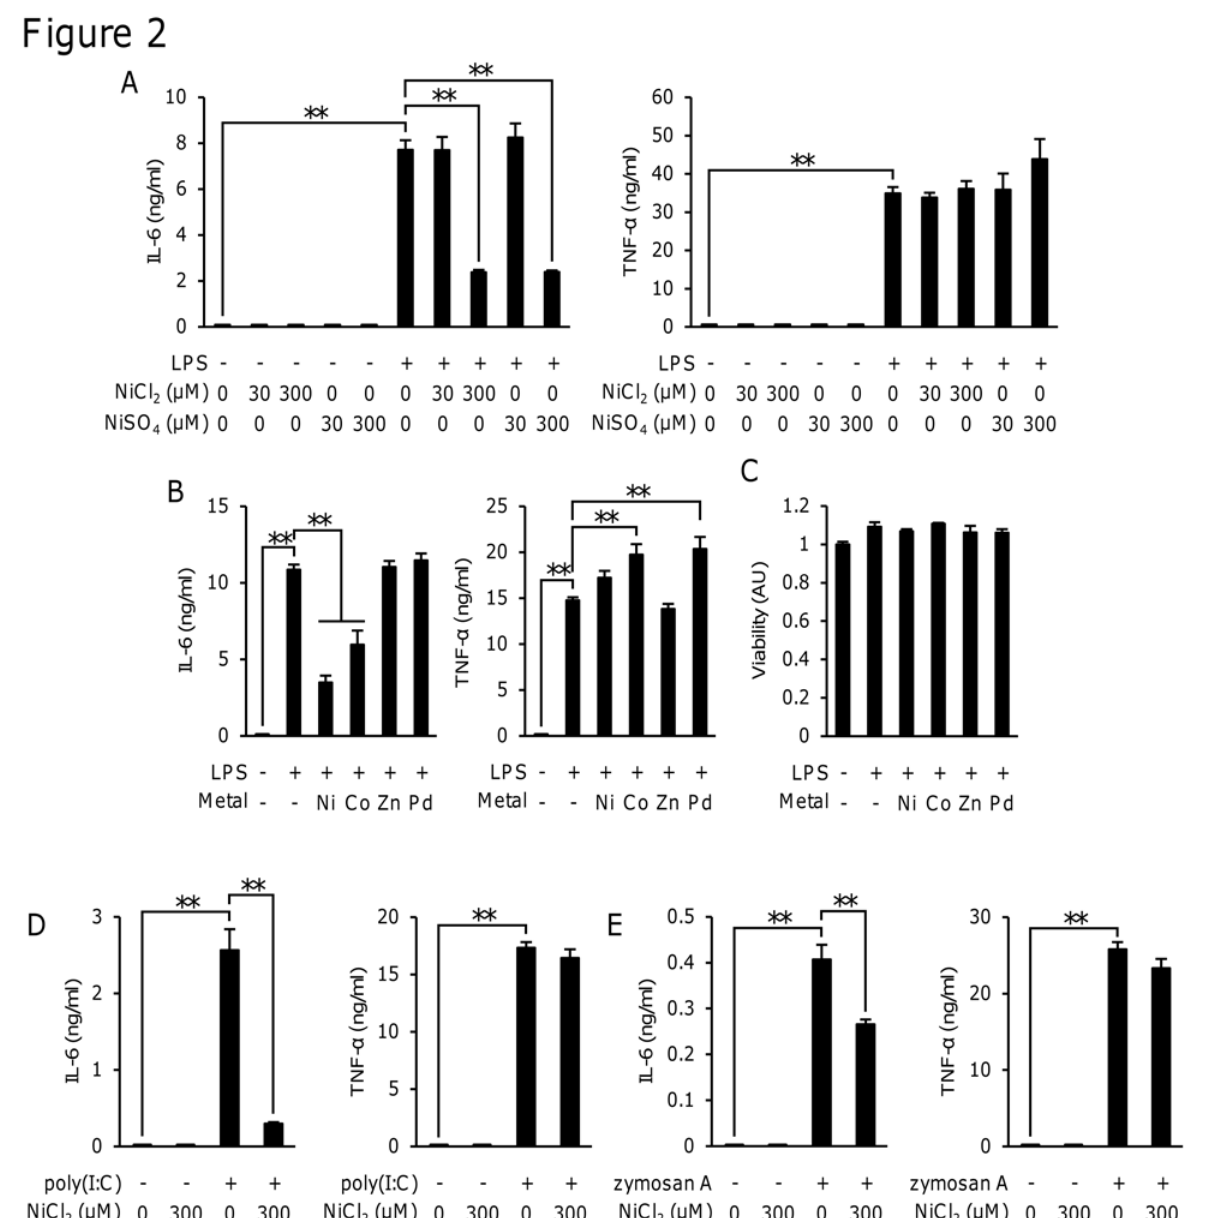
Fig 2. Effects of various metal ions on the LPS-induced production of IL-6 and TNF- α in RAW264 cells. RAW264 cells were incubated for 8 h in medium containing LPS (1 μ g/ml) (A, B, and C), poly(I:C) (50 μ g/ml) (D), or zymosan A (500 μ g/ml) (E) in the presence or absence of NiCl 2 or NiSO 4 at the indicated concentrations, or 300 μ M of NiCl 2 , CoCl 2 , ZnCl 2 , or PdCl 2 (B and C). The concentrations of IL-6 and TNF- α in the medium were determined by ELISA and cell viability was determined by the MTT assay. The mean value of the control was set to 1.0 (C). Data represent the mean ± S.E.M. ( n = 3, 4). ** p < 0.01 between the indicated groups. Data are representative of three independent